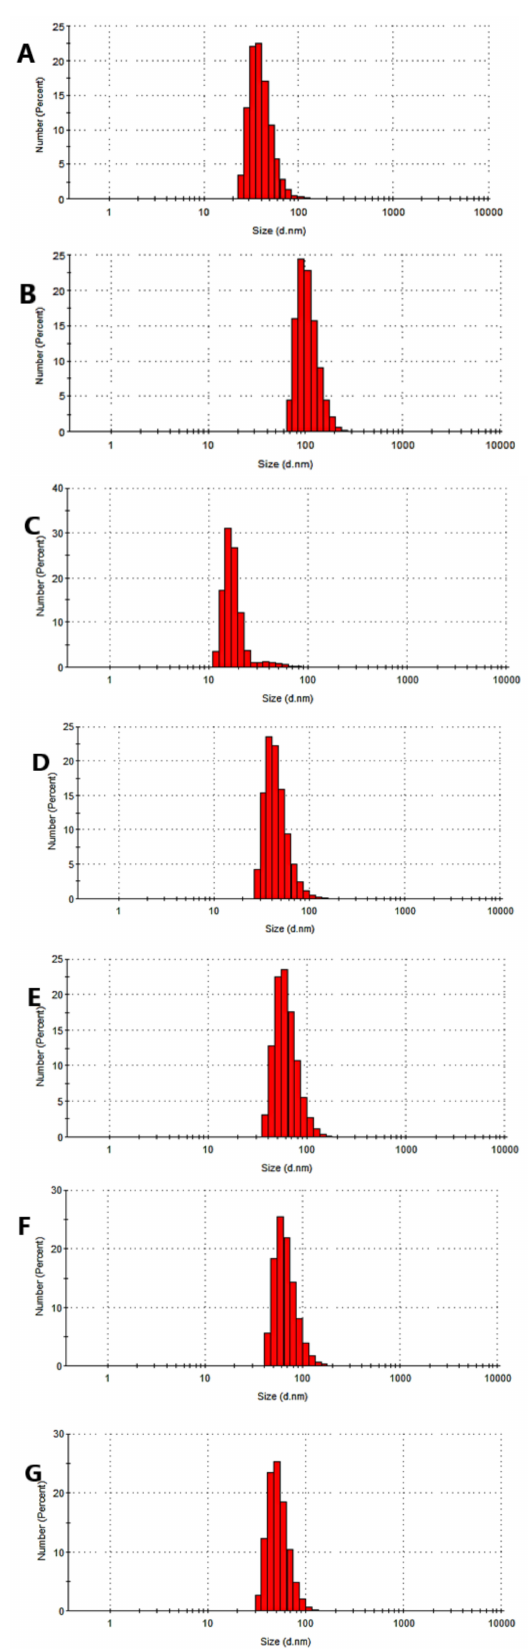
Figure 2. Droplet size distribution of the samples obtained with DLS measurements: N0 ( A ), N1 ( B